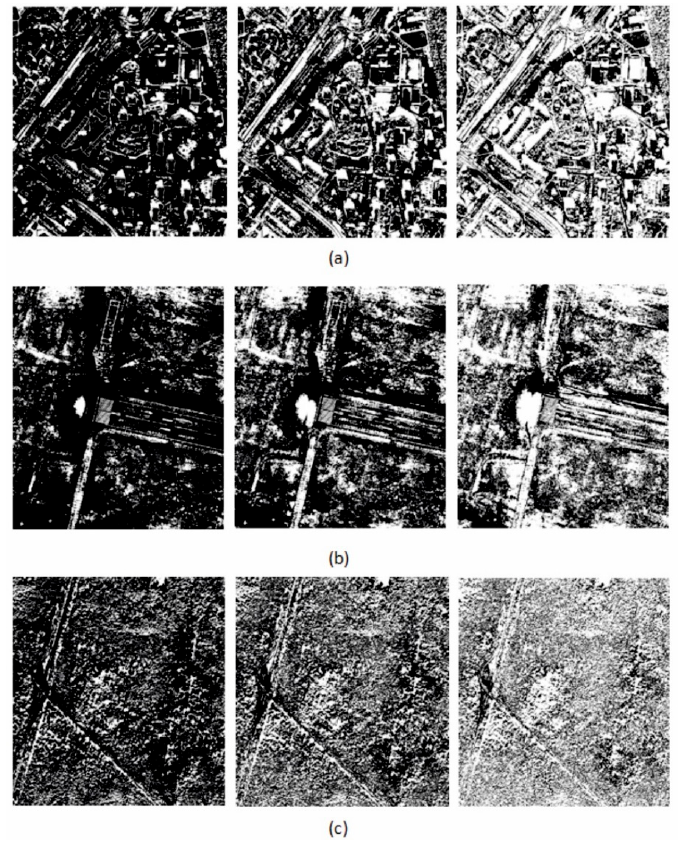
(cid:12) (cid:12) (cid:12) (cid:12) (cid:12) d i , j (cid:12) does not